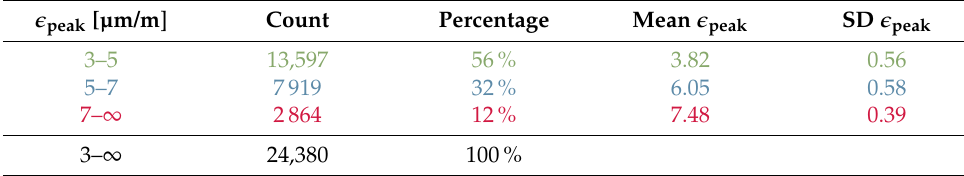
Table 1. Count, mean value and deviation in each category of peak